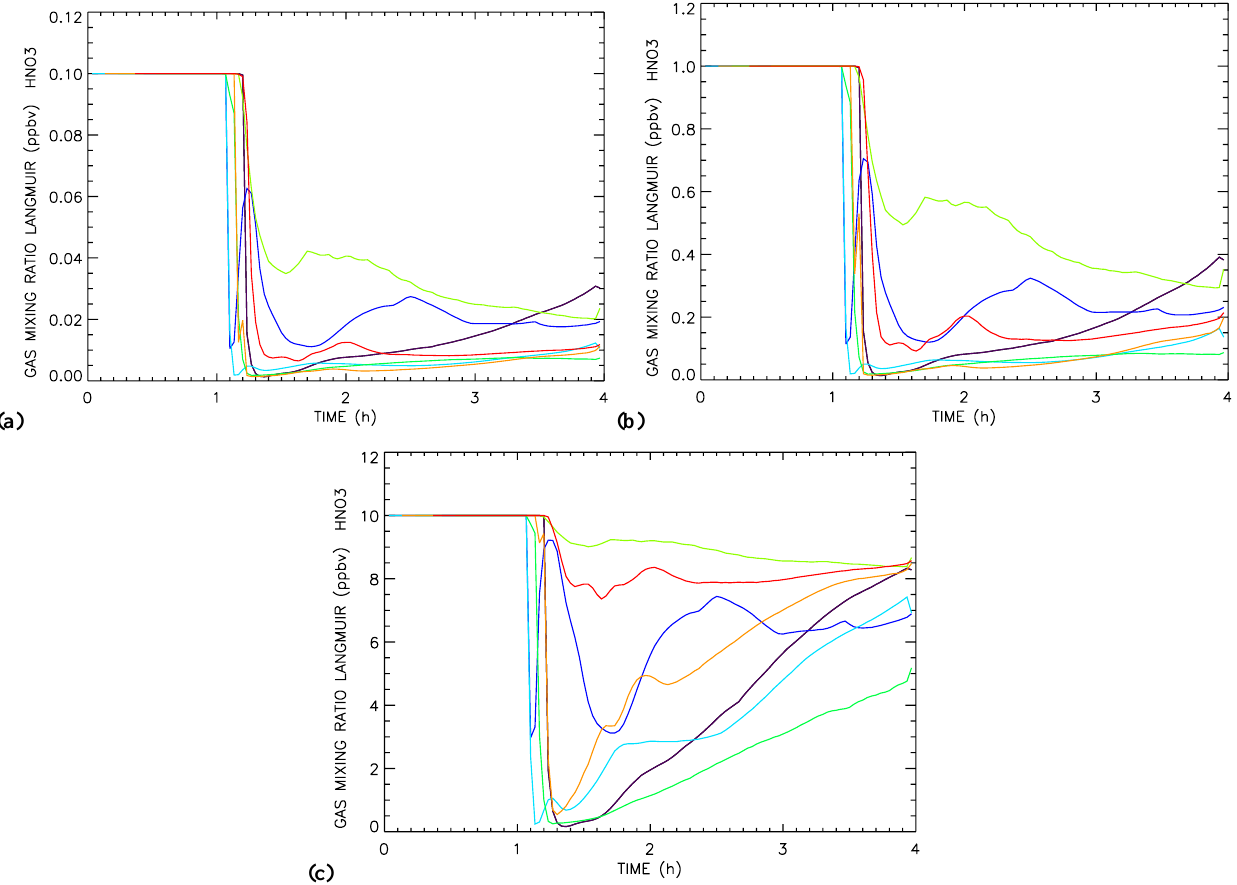
Fig. 10. Results of the Langmuir approach. HNO 3 gas mixing ratio versus time along the selected trajectories from the REF simulation using an initial gas mixing ratio of (a) 0.1ppbv, (b) 1ppbv and (c)